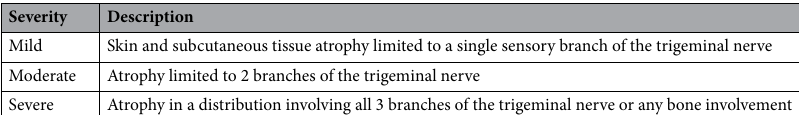
Table 1. The severity of Parry–Romberg syndrome is divided into mild, moderate and